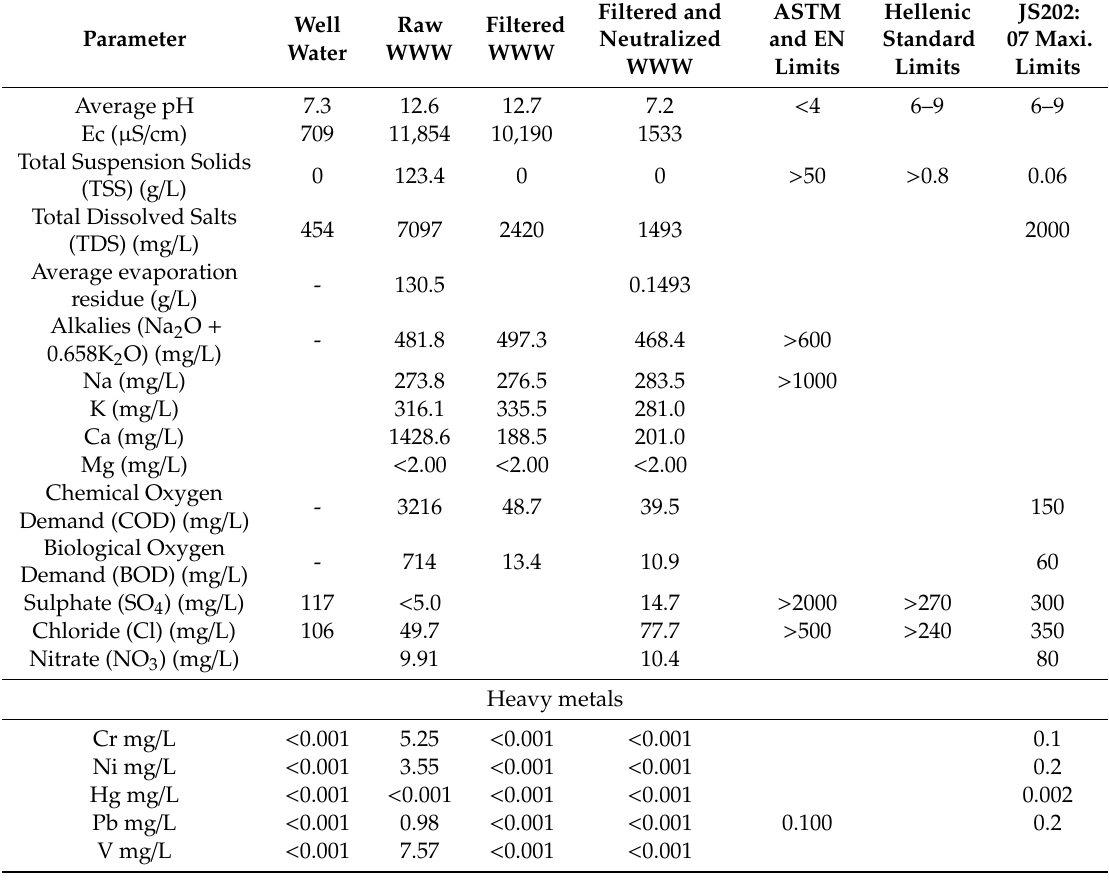
Table 6. The chemical and physical properties of the used water samples and the standard maximum concentration limits for mixing water as well as the Jordanian standard specifications limits of industrial reclaimed waste water in the event e ffl uent water is discharged into valleys and